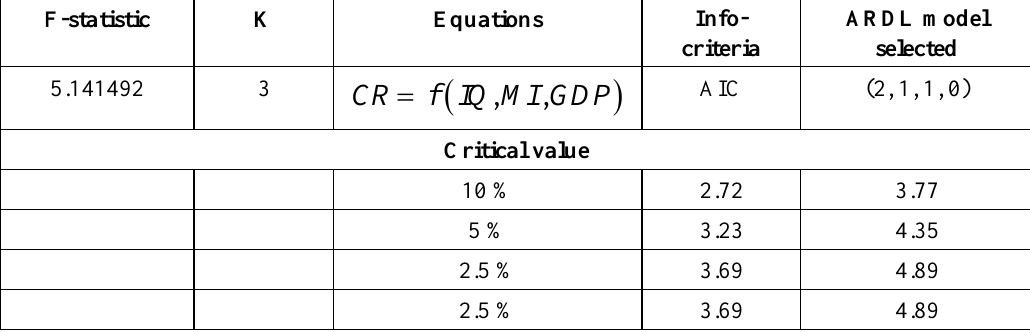
Table 2. Bound Test Approach to